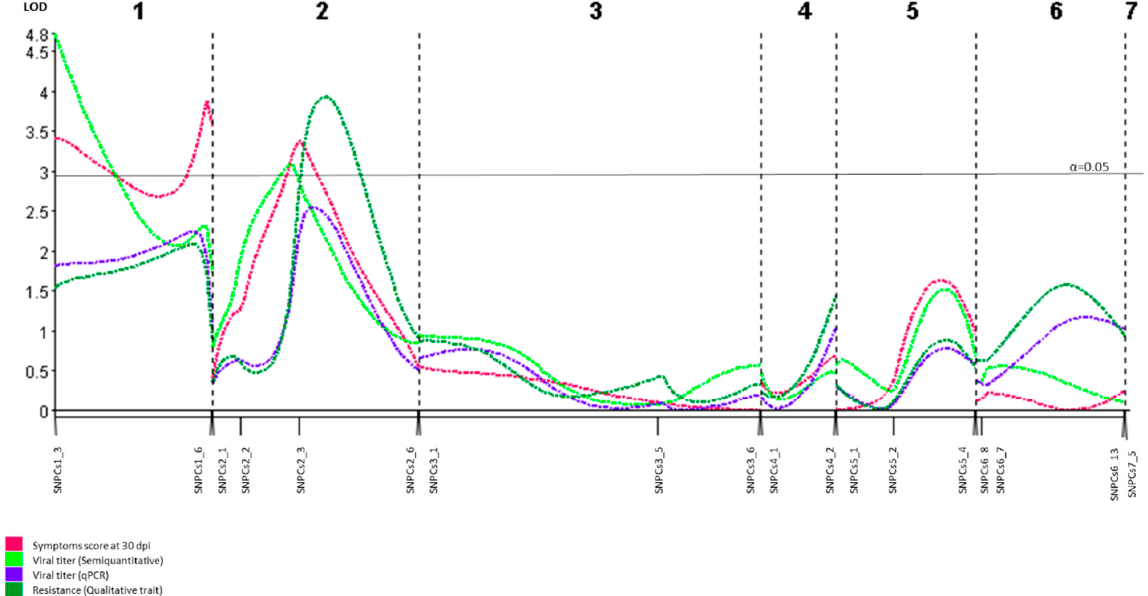
Figure 5. QTL analysis of F 2 (CGN23089-2 x BGV011742) using symptom score at 30 days after mechanical inoculation (dpi), viral titers of ToLCNDV at 30 dpi (semiquantitative and quantitative detection) and qualitative resistance as traits.